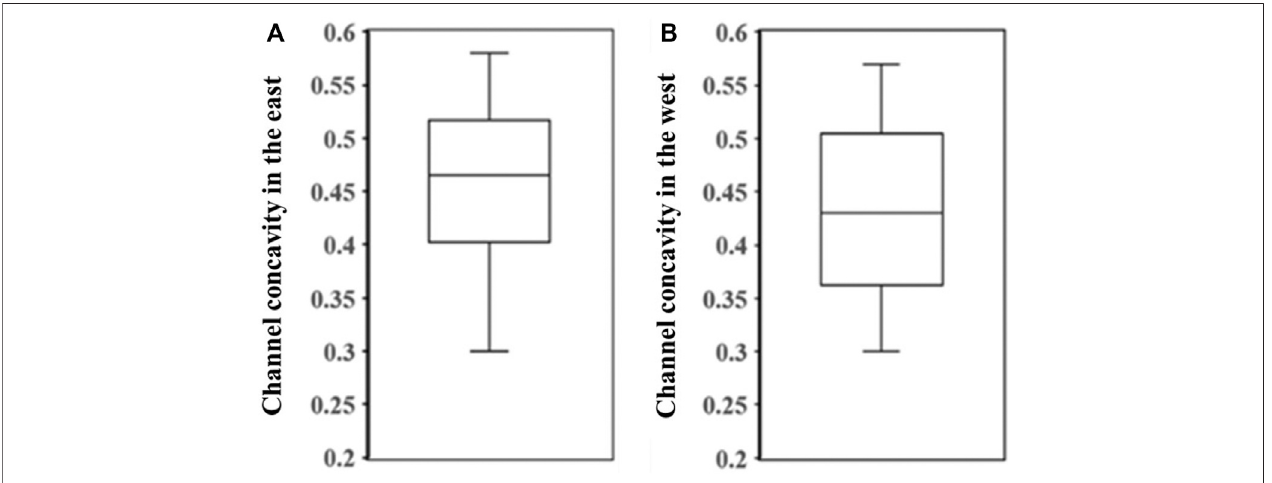
FIGURE11| ChannelconcavityindexintheeastoftheGreaterKhinganMountains (A) .Channelconcavityindex inthewestoftheGreaterKhinganMountains (B) .